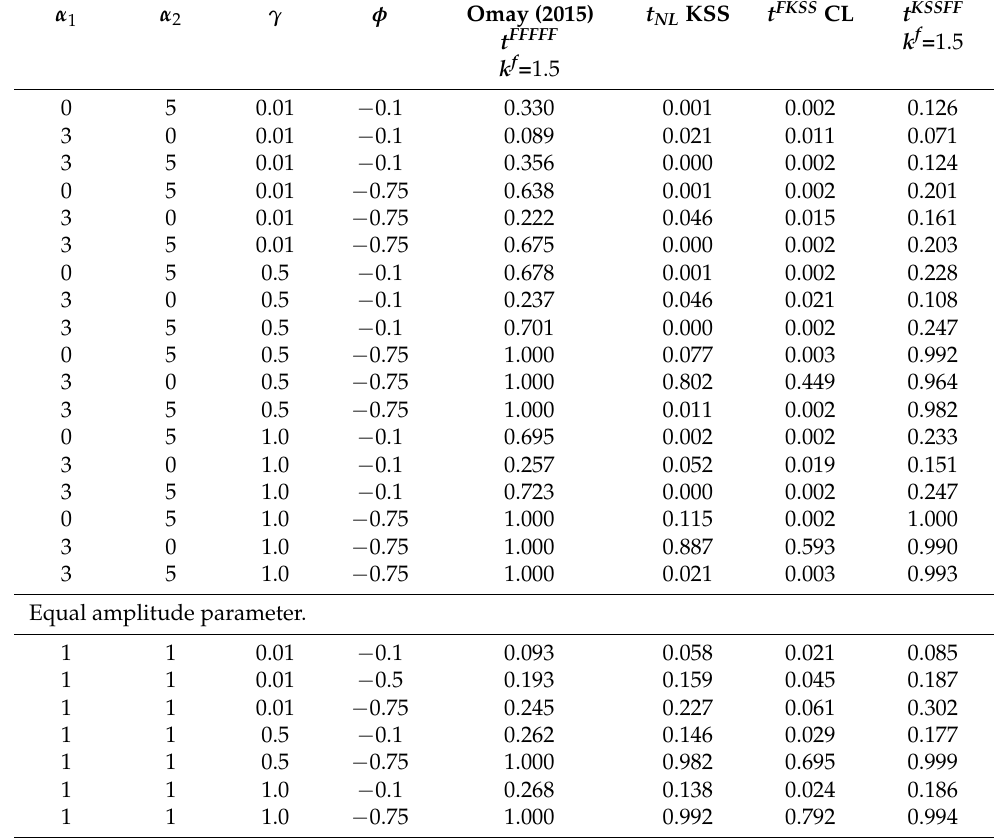
Table 6. Power analysis with KSS-FF